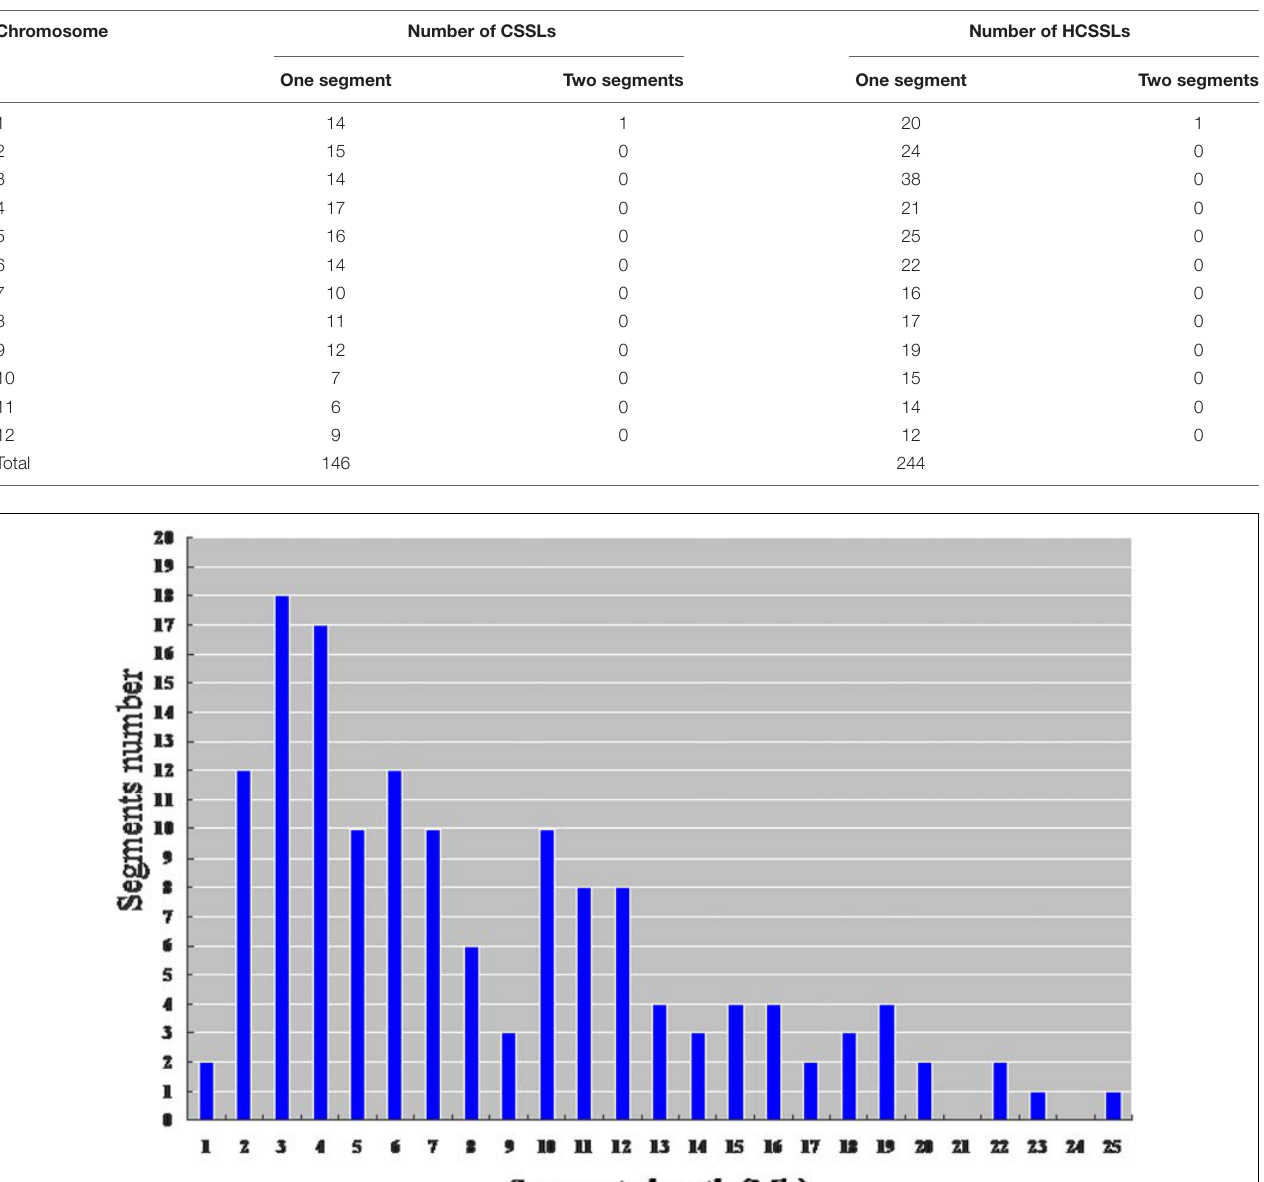
TABLE 2 | Segments carried by CSSLs and HCSSLs.